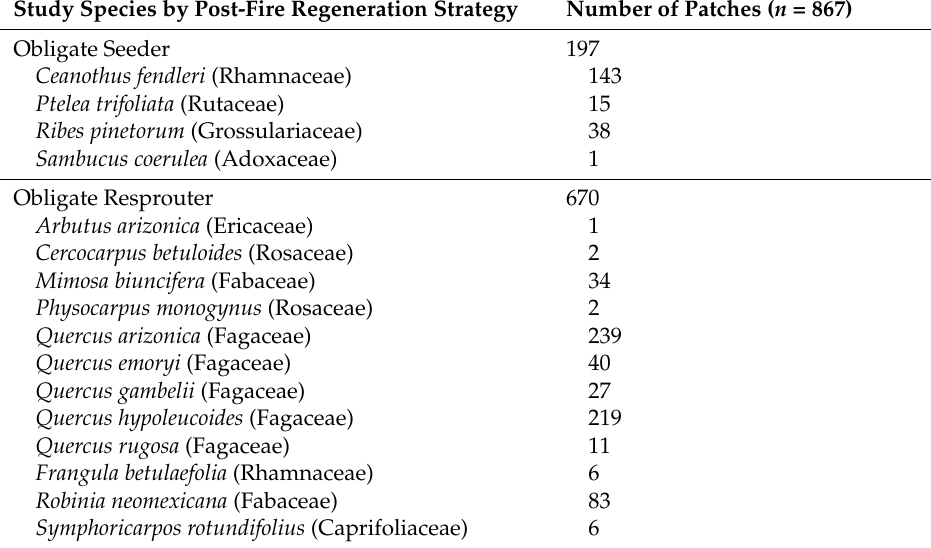
Table A1. Species identified in sampling plots, categorized by post-fire regeneration strategies based on the Fire Effects Information System (FEIS)